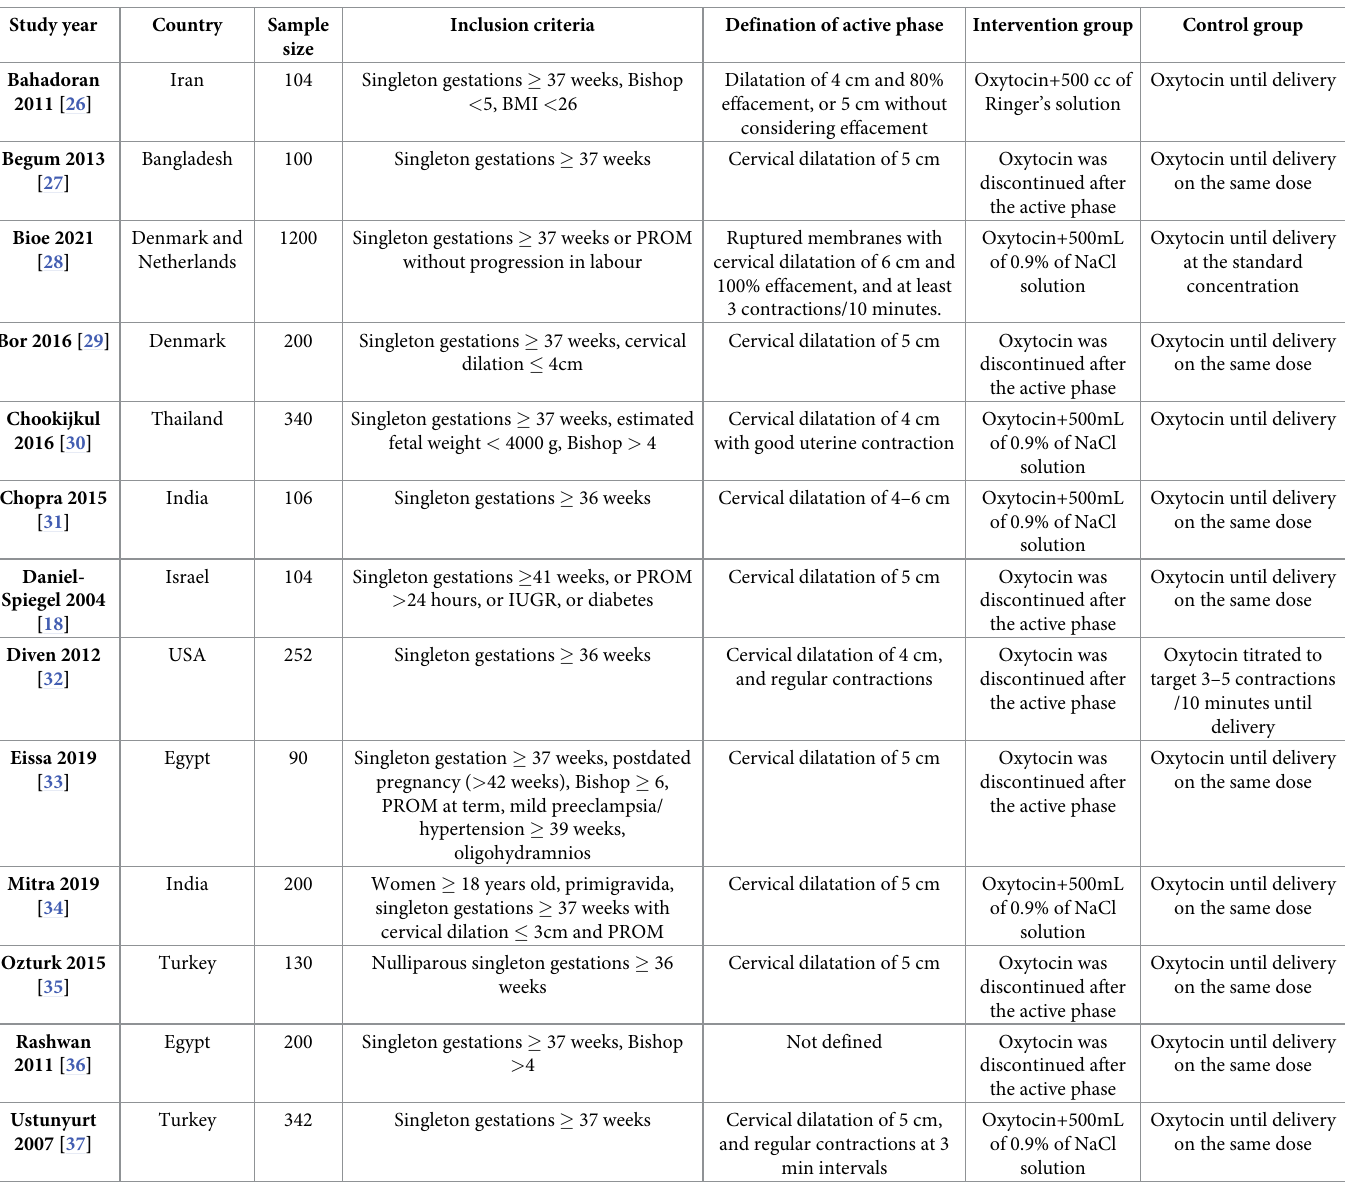
Table 1. Characteristics of the included